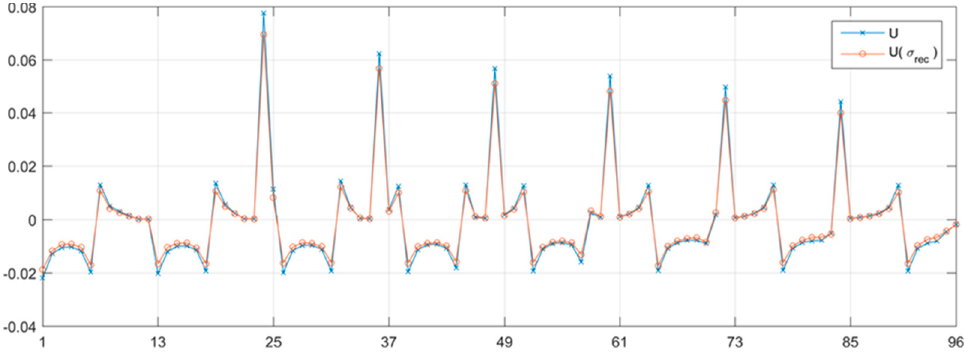
Figure 12. Electric voltages validation with ANN method. Table 2. Preliminary evaluation of algorithmic methods through voltages.